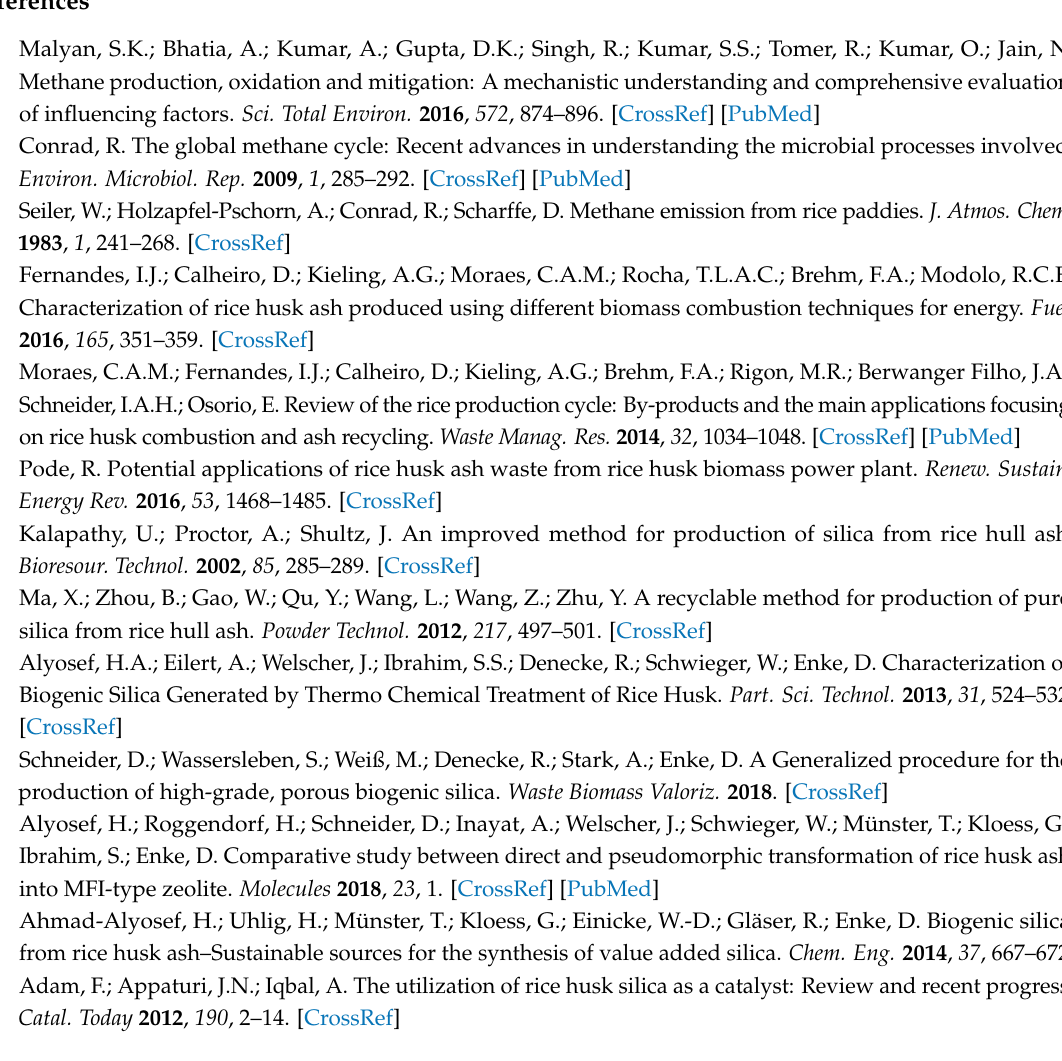
Figure S1: EDX analysis of fresh 0.6Pd/CeO 2 /RHS, Figure S2: EDX analysis of spent 0.6Pd/CeO 2 /RHS. Figure S3, Electron microscopy: TEM image of catalyst 0.6Pd/CeO 2 /RHS (fresh), overview, Figure S4: XRD pattern of RHS, Table S1: Elemental content of the RHS support determined by ICP-OES (without